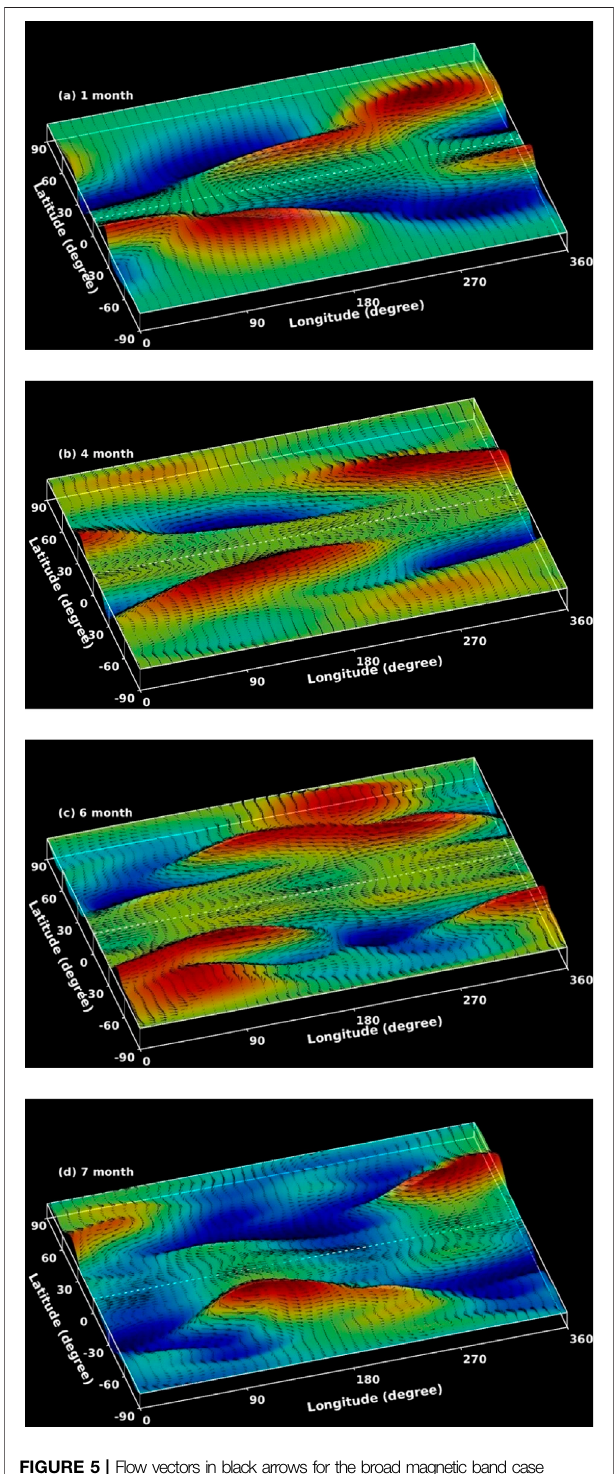
FIGURE 5 | Flow vectors in black arrows for the broad magnetic band case superimposed on tachocline top surface, which is presented in rainbow colormap. Againasin Figure4 ,red/orangerepresentsbulgesanddeep-blue/bluethedepression in plasma fl uid. Panels (A – D) show the corresponding snapshots as in Figures 4A – D ,nonuniformlyselectedrespectivelyat1,4,6and7 months.But,unlike Figure4 , only the fl ow-component for nonzero longitudinal wavenumbers presented here, in